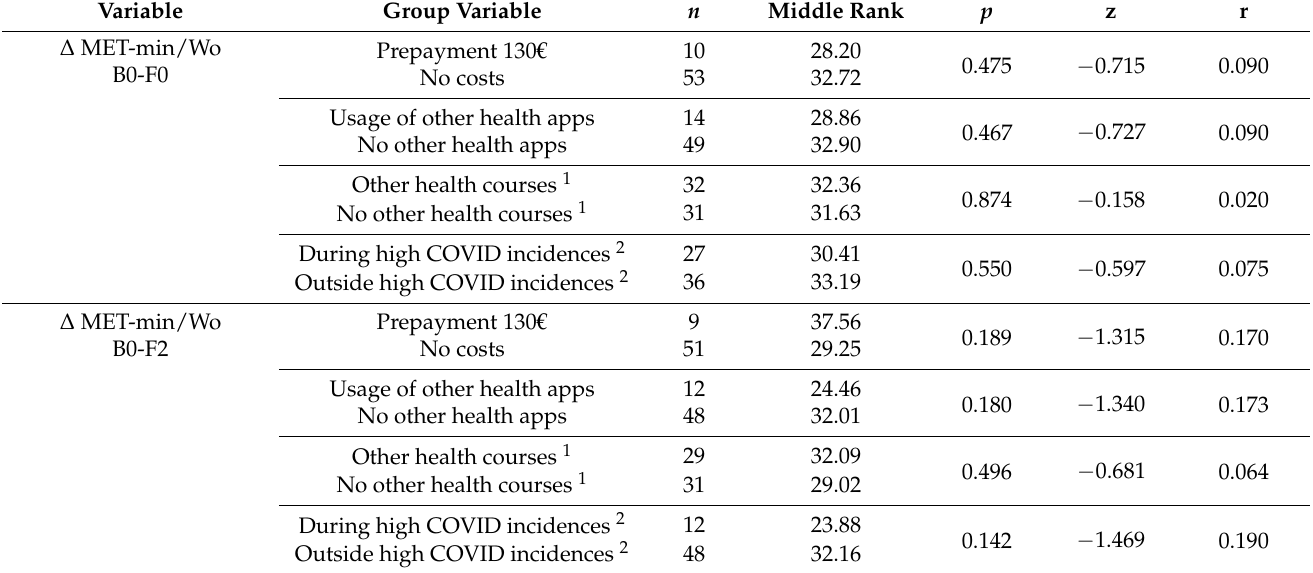
Table A11. Mann-Whiney-U test: Influence of different factors on the effect of the app on the physical activity between the different measurement points and